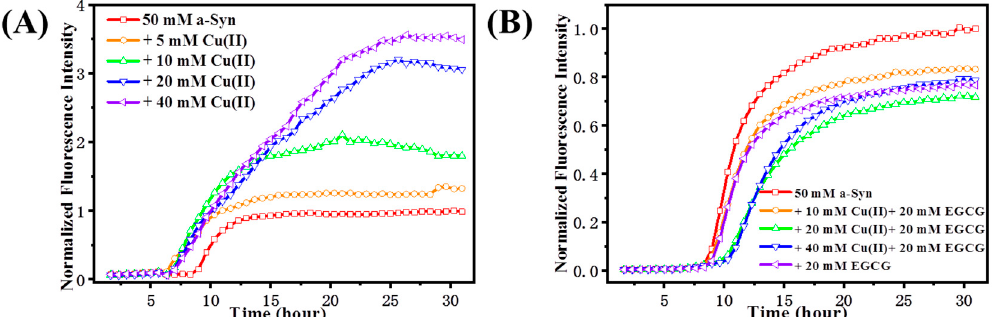
Figure 2. ThT fluorescence of α -Syn with Cu(II) and EGCG presence. ( A ) The fibrillation kinetics of 50 µ M α -Syn in the absence or presence of 10, 20, and 40 µ M Cu(II), respectively. ( B ) The fibrillation kinetics of 50 µ M α -Syn incubated with Cu(II) concentration of 0, 10, 20, and 40 µ M and EGCG constant concentration of 20 µ M. The maximum fluorescence intensity of control group (50 µ M α -Syn) was normalized as 1.0, the intensities for other groups were referred to